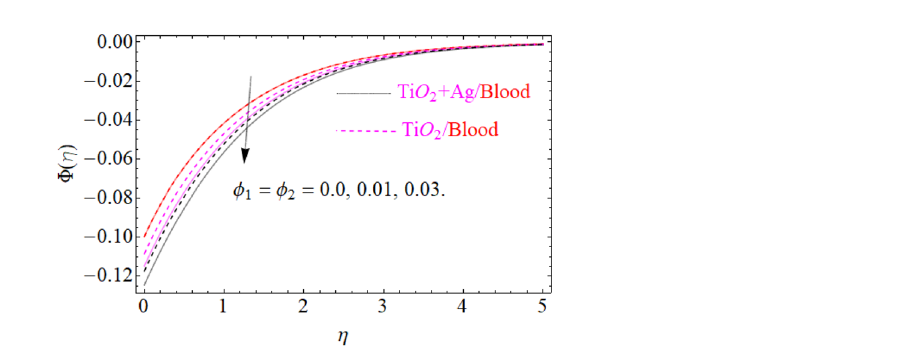
Figure 15. Under the influence of (φ 1 , φ 2 ) (nanoparticle concentration parameter), �(η)